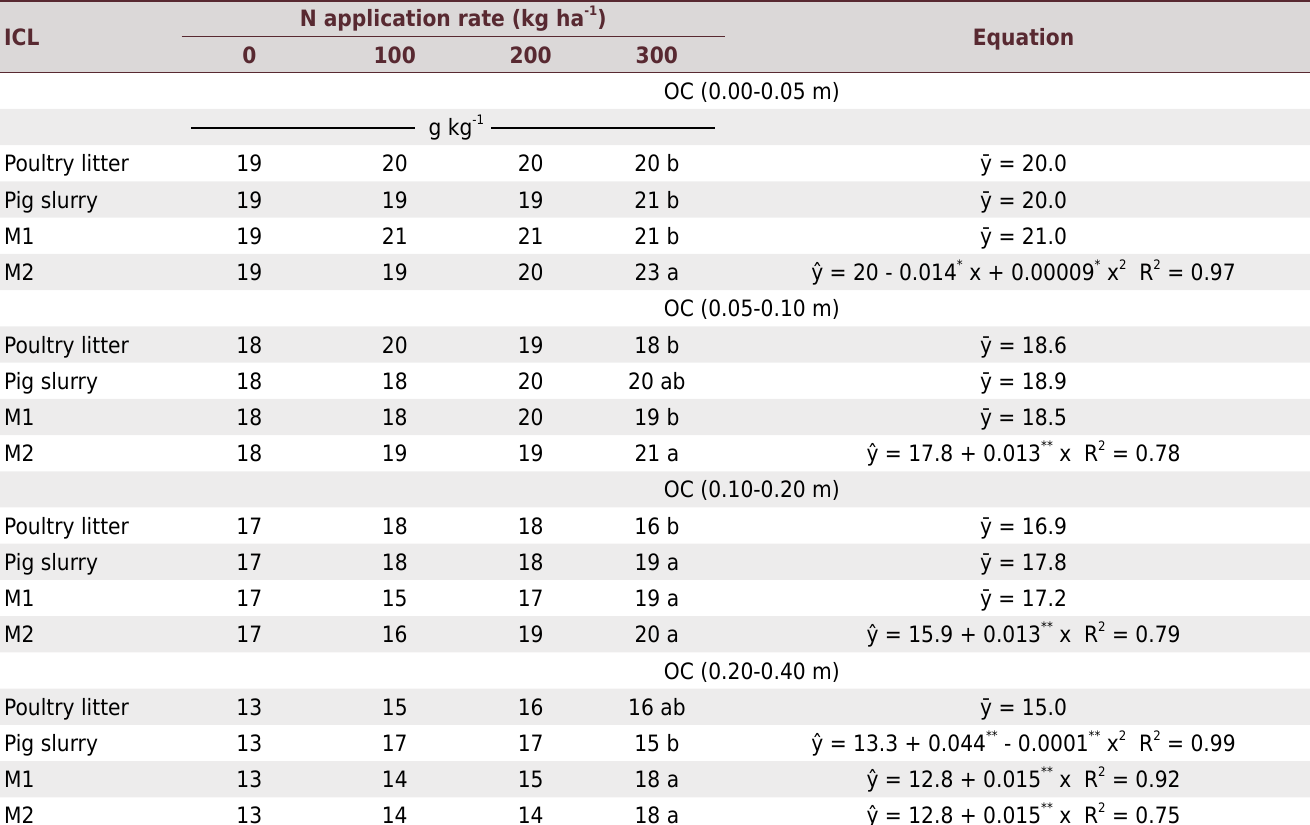
Table 3. Soil organic carbon content (OC) according to organic and mineral fertilizer application in integrated crop-livestock systems in 2013 N application rate (kg ha -1 ICL